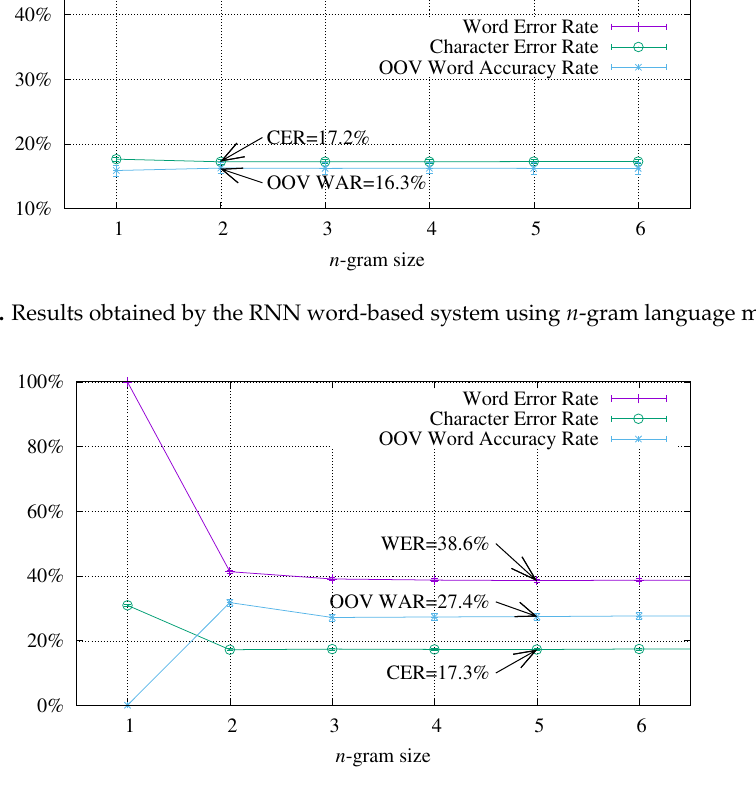
Figure 15. Results obtained by the RNN sub-word-based system using n -gram language